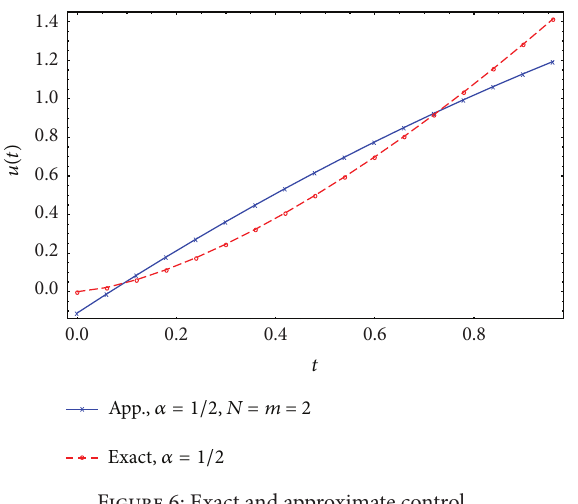
Figure 6: Exact and approximate control.